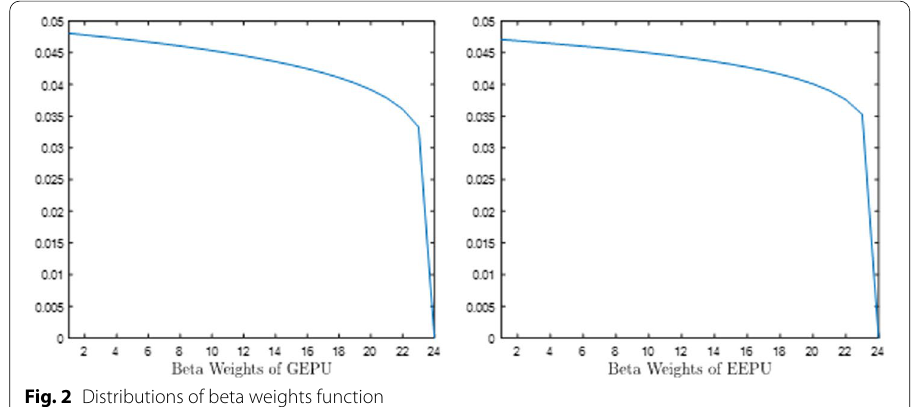
Fig. 2 Distributions of beta weights